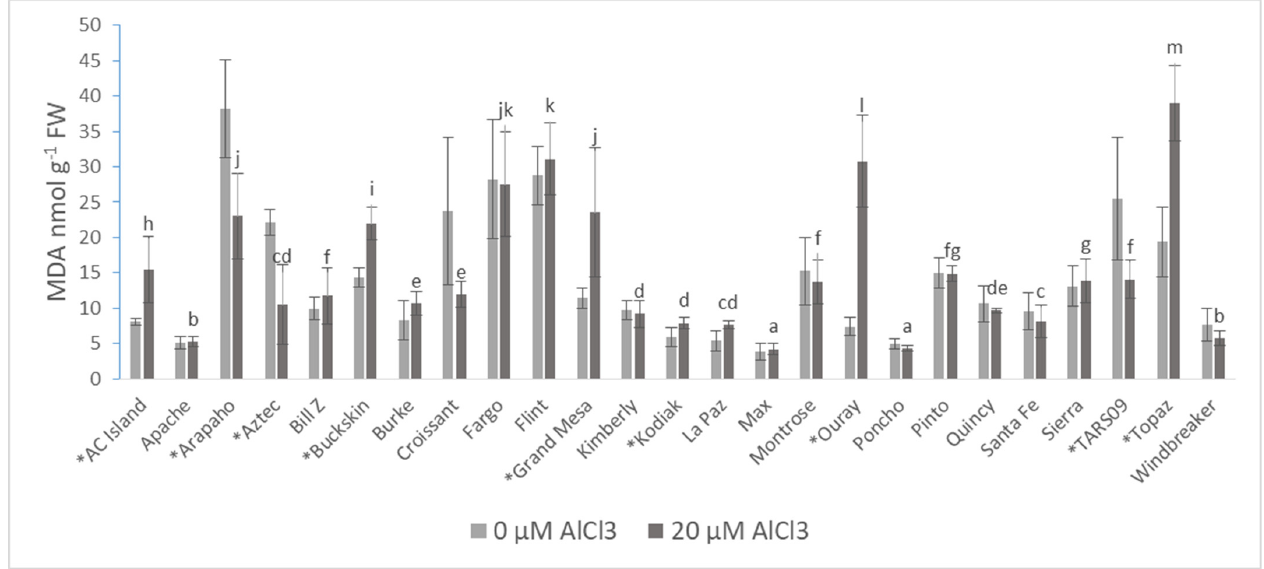
Figure 3. The peroxidase (POD) activity of 25 common bean cultivars 72 h after AlCl 3 treatment. Values are the averages of five biological and technical repetitions ± SD. * Significant difference between treatments based on Shapiro–Wilk test ( p ≤ 0.05). Lowercase letters denote a significant difference among the AlCl 3 -treated cultivars. FW: fresh weight.